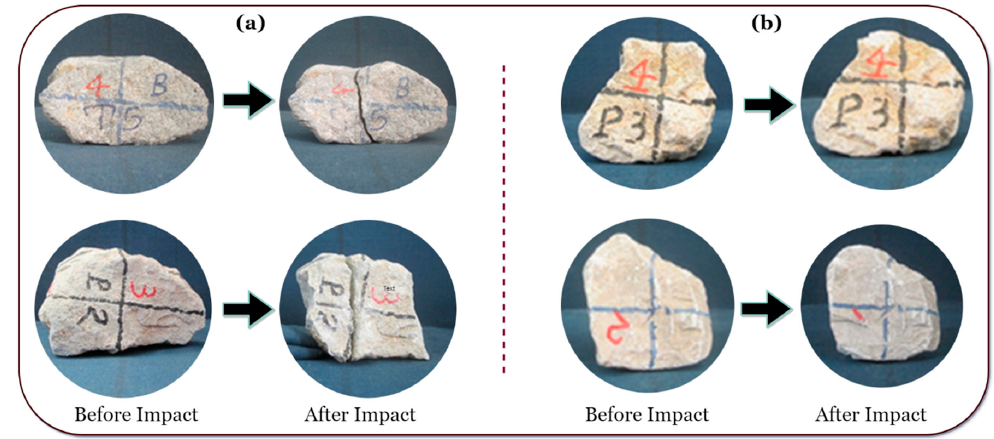
Figure 9. Comparison of ballast degradation patterns: ( a ) fragmentation; ( b ) abrasion [18].